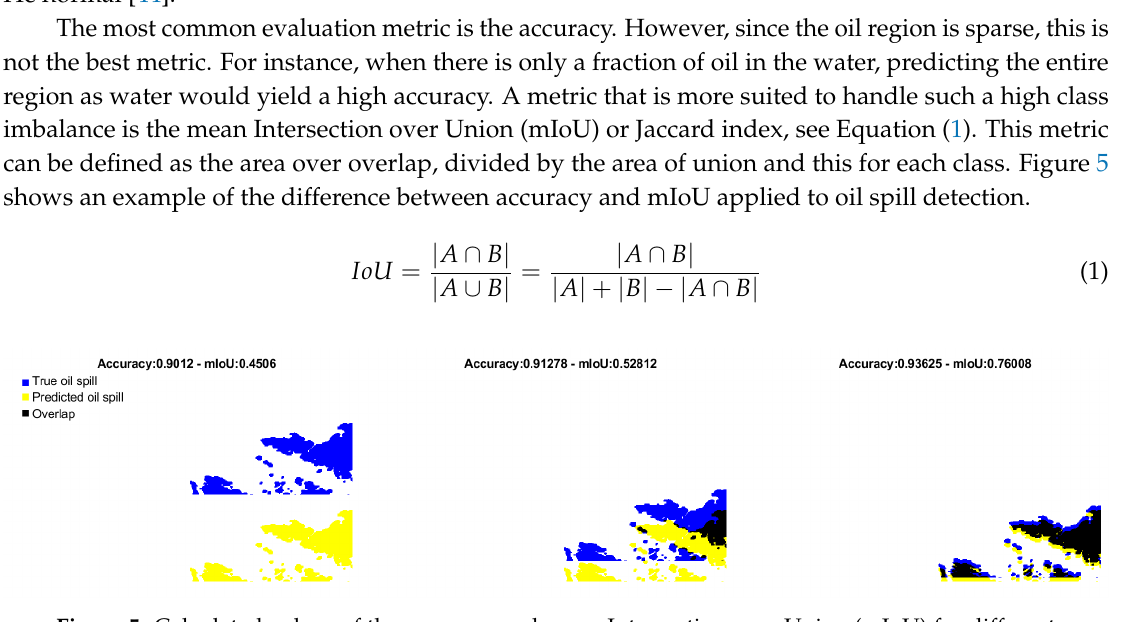
Figure 5. Calculated values of the accuracy and mean Intersection over Union (mIoU) for different cases. A high accuracy does not implicate a good overlap in our